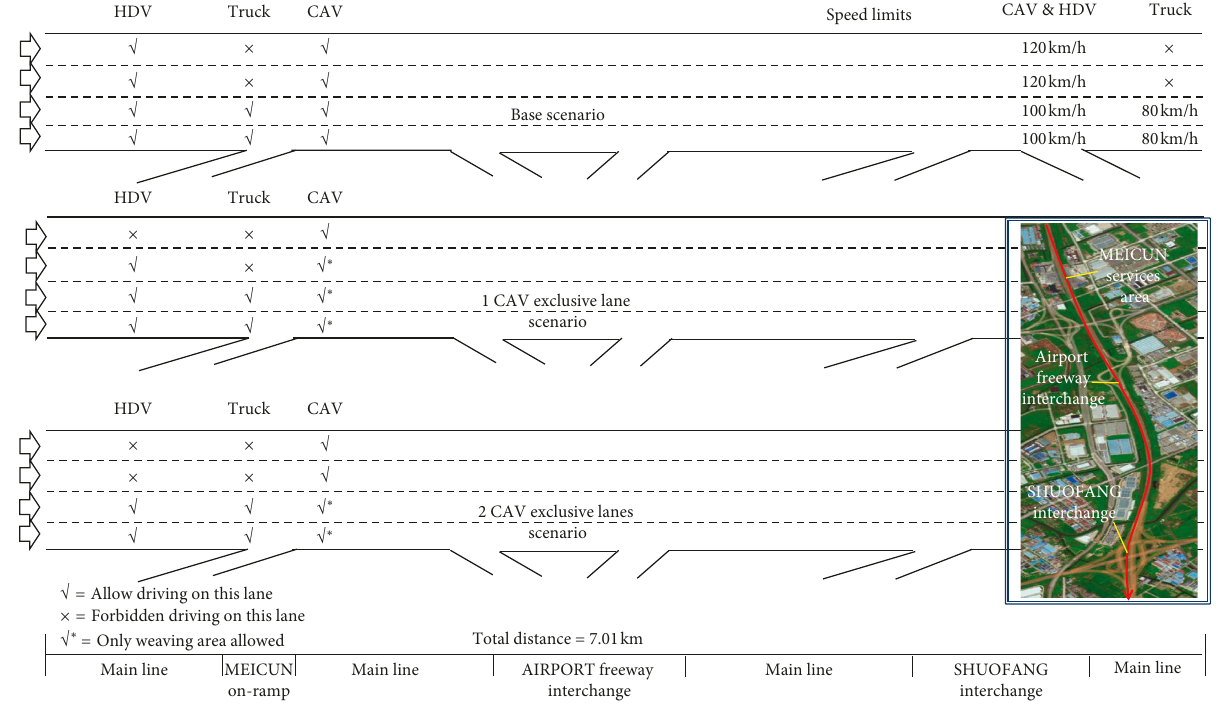
Figure 3: Description of three deployment